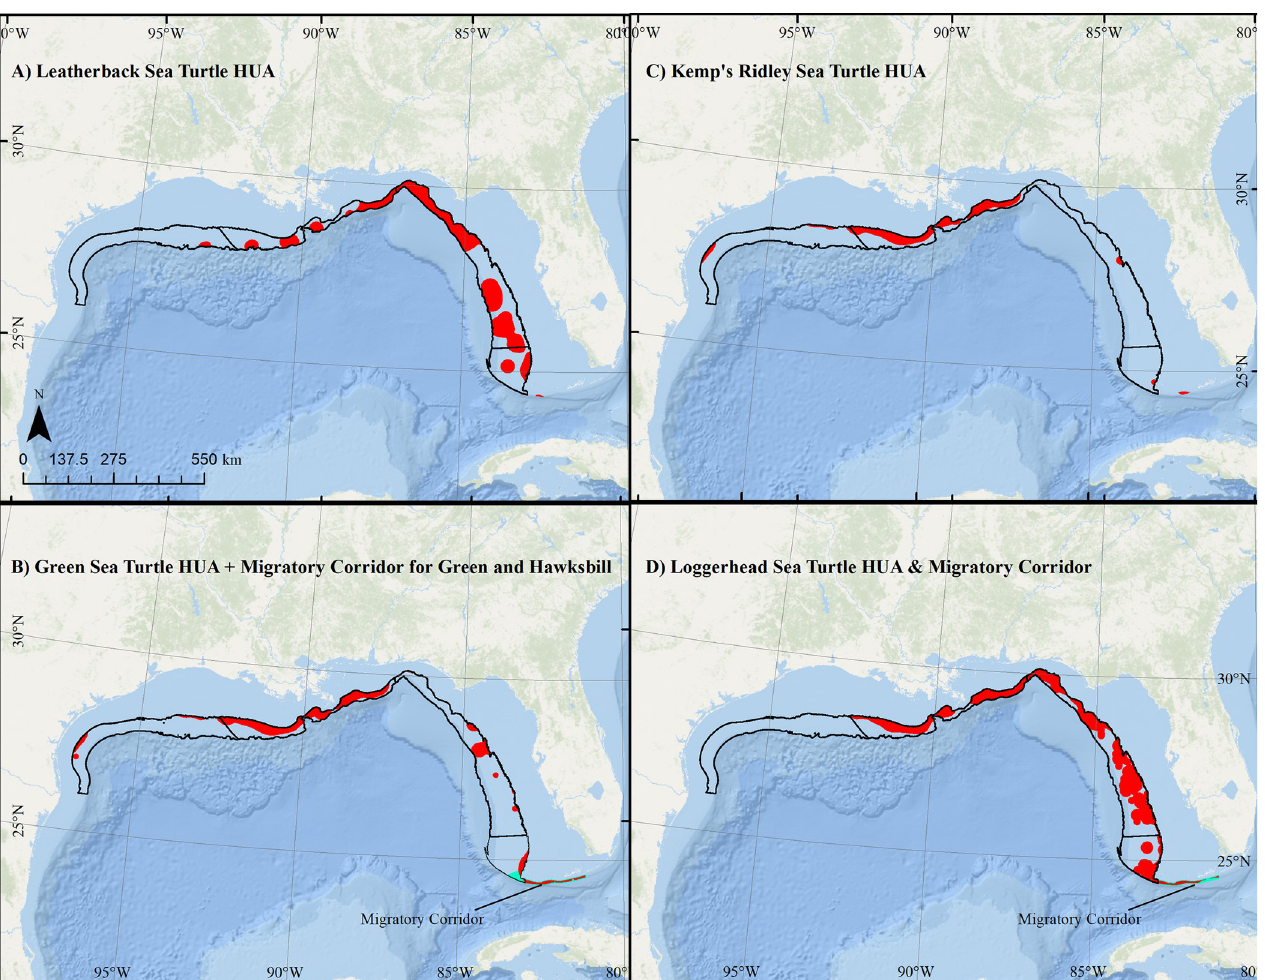
Fig 5. Distribution of sea turtles. High use areas (HUA; red) and migratory corridors (blue) for A) Leatherback sea turtle B) Green and hawksbill sea turtles; C) Kemp’s ridley sea turtle; and D) Loggerhead sea turtles relative to proposed aquaculture study areas (black). Note, due to insufficient data, no high use areas were identified for hawksbill sea turtles within the aquaculture study areas. Map developed in ESRI ArcGIS 10.8.1. Basemap from Esri Ocean Basemap and its partners, reprinted from ESRI under a CC BY license, with permission from ESRI, original copyright 2022. Projection: UTM NAD83 Zone